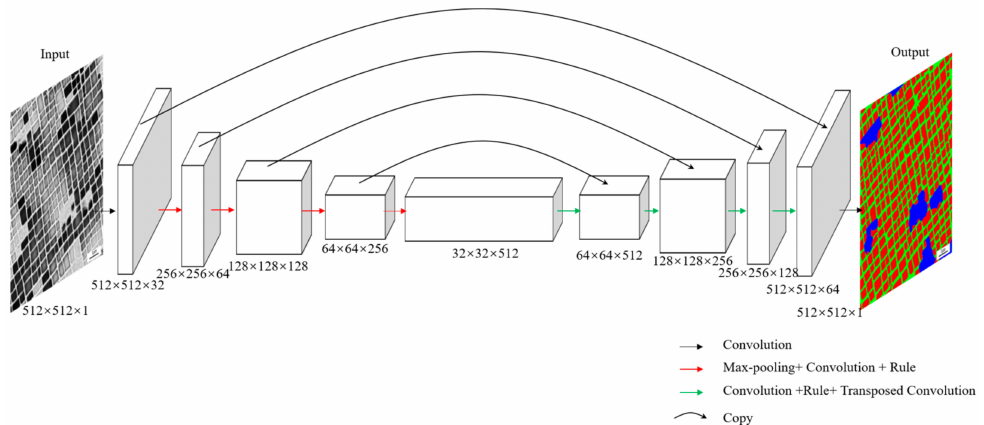
Figure 5. Image segmentation network